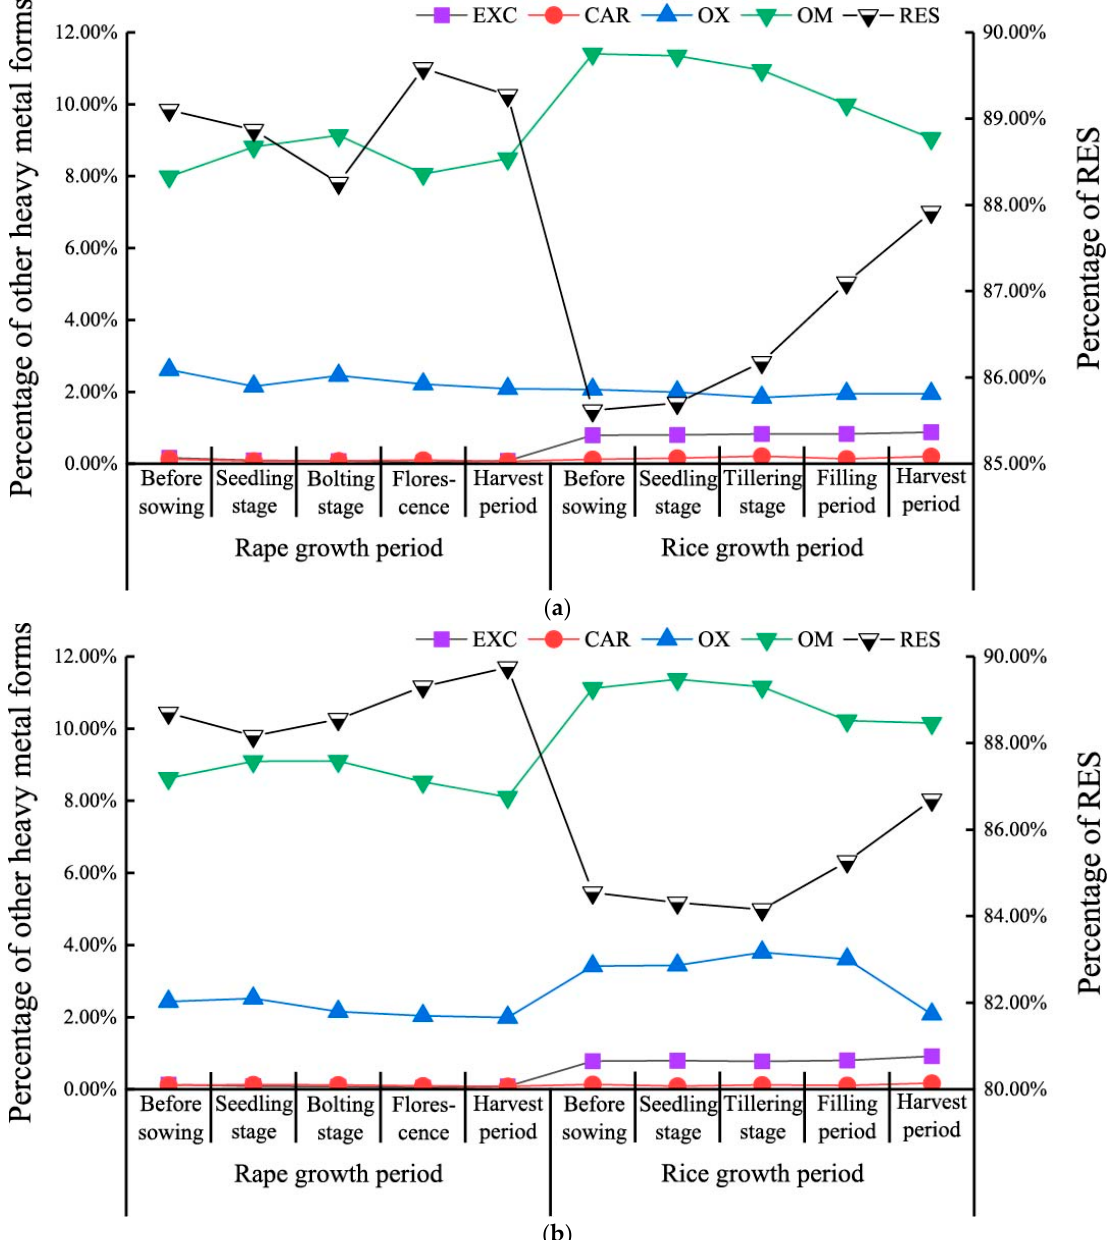
Figure 2. Speciation variation of soil Cr under rape-rice rotation mode. (Notes: ( a ) is 0–20 cm, ( b ) is 20–40 cm, EXC is the exchangeable fraction, CAR is carbonate fraction, OX is iron-manganese oxide bound fraction, OM is organic-bound fraction, RES is residual fraction).